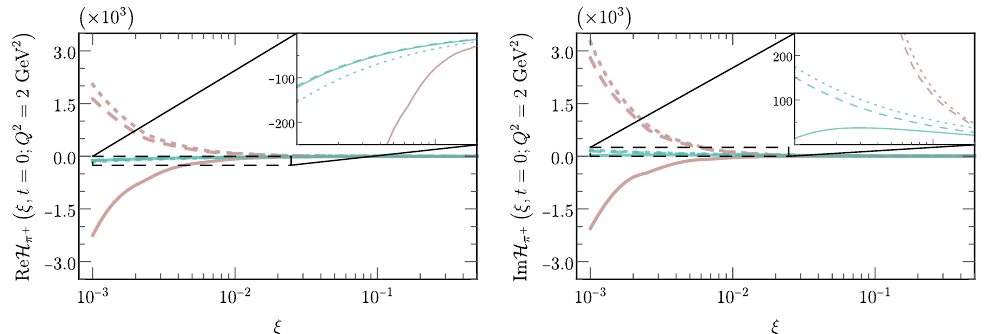
Figure 13. Real ( left ) and imaginary ( right ) parts of DVCS Compton Form Factors computed with theoretically complete model developed in ref. [58] (brown curves). Dotted lines correspond to LO computation, dashed lines—to NLO without gluon contributions and the solid lines to the full NLO computation. The light blue curves are built from standard phenomenological Anzätze in the GPD framework [55], and a phenomenological forward limit [58,154] for